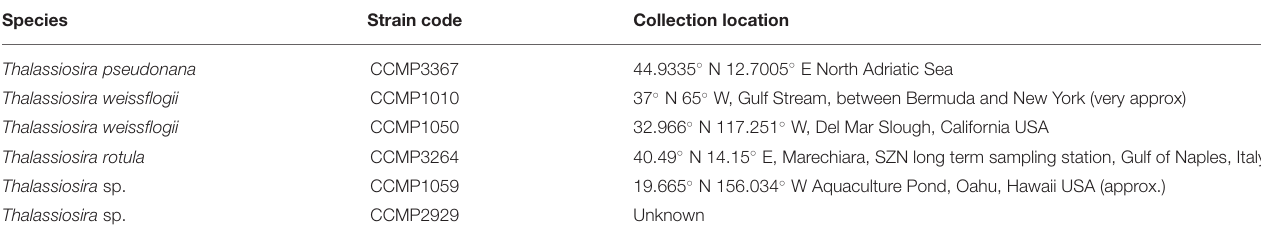
TABLE 1 | Domesticated Thalassiosira strains used to develop and test the QPA, including species identification and location collection. Species Strain code Collection